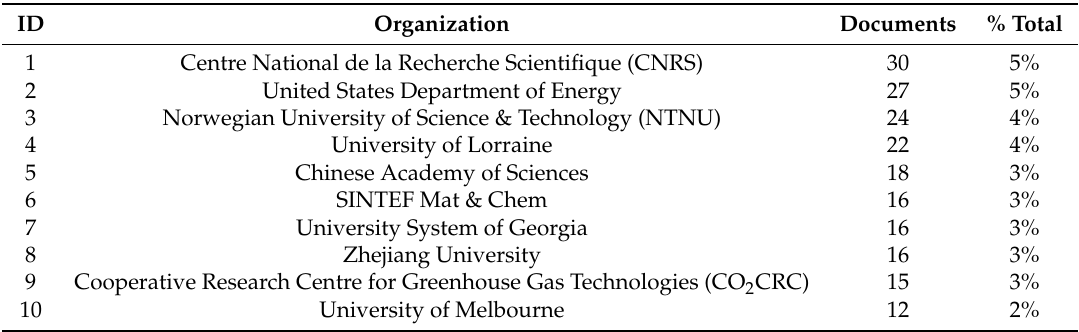
Table 1. Top 10 organizations producing scientific papers related to carbon capture using membranes. ID Organization